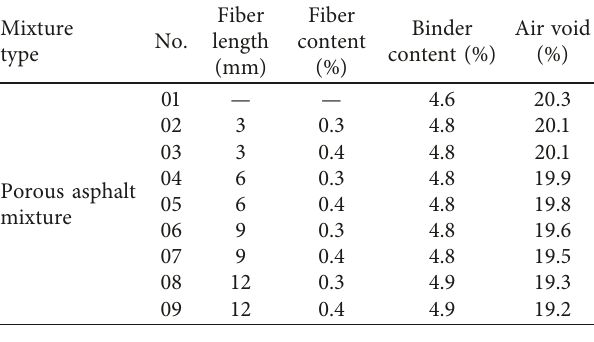
Table 8: Design parameters of each porous asphalt